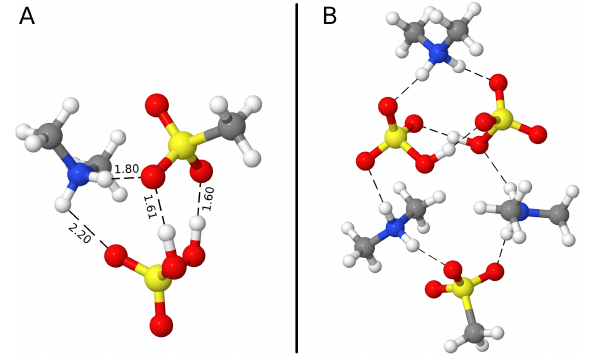
Figure 1. A: Most stable configuration of the MSA · H 2 SO 4 · DMA cluster. The lengths of the hydrogen bonds are given in Å. In this cluster, MSA is a stronger acid than H 2 SO 4 . B: Configuration of the MSA · (H 2 SO 4 ) 2 · DMA 3 cluster. As with all investigated clusters, the most stable structure is more monolayer-like than bulk-like. The hydrogen bonds are shown as dashed